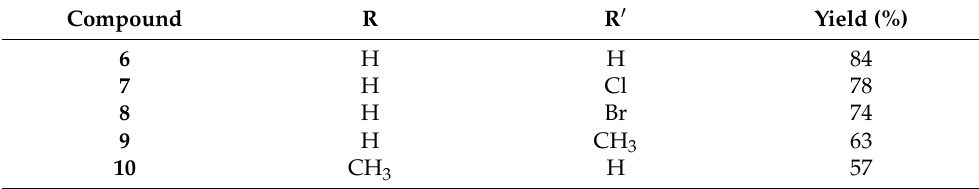
Table 2. Substitution patterns in Type II chalcones and the reaction